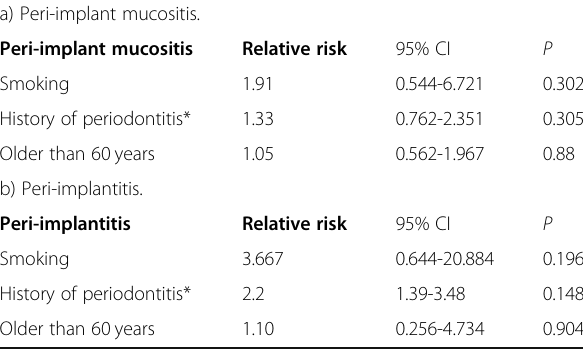
Table 5 Association between patient-related factors and peri-implant diseases a) Peri-implant